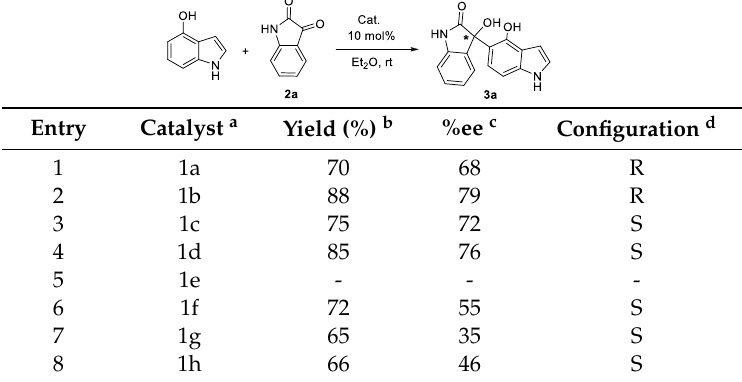
Table 1. Asymmetric hydroxyalkylation of 4-hydroxyindole with isatin a .